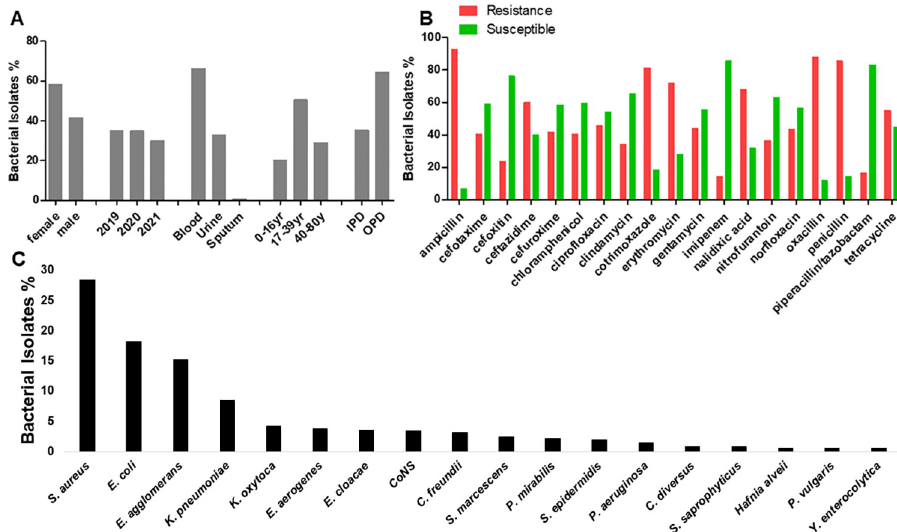
Fig 1. Characterization of bacterial isolates from blood, urine, and sputum specimens. (A) Bacterial isolates in percentages based on patient gender, year of isolated, sample type age and location; Majority specimens were blood and urine received from female patients, and from the OPD. (B) The susceptibility patterns (in percentages) against common utilized antibiotics. Multidrug resistance is presented with imipenem showing effectiveness. (C) Bacterial isolate from blood, urine, and sputum specimens in percentages. The graph shows S . aureus as a common isolate and Y . enterocolytica as least isolate at LCH. CoNS: Coagulase negative Staphylococci, IPD: in-patient department, OPD: out-patient department, yr/y: